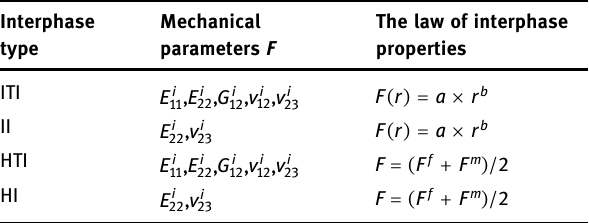
Table 6: Elastic properties and their determination methods of